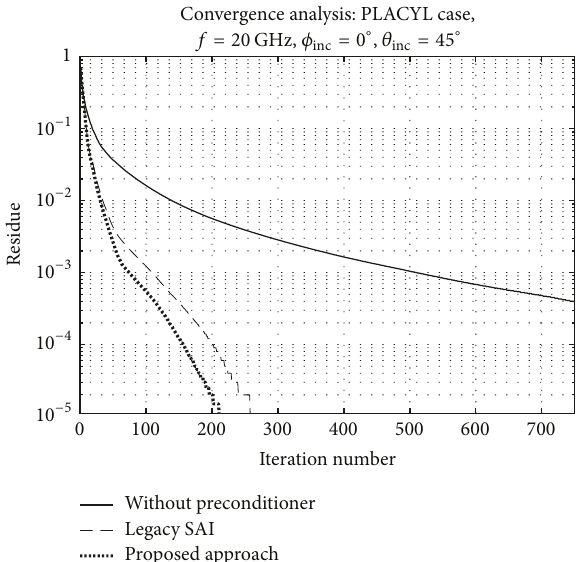
Figure 7: Bistatic RCS results for the Opel Astra car, 𝑓 = 5.9